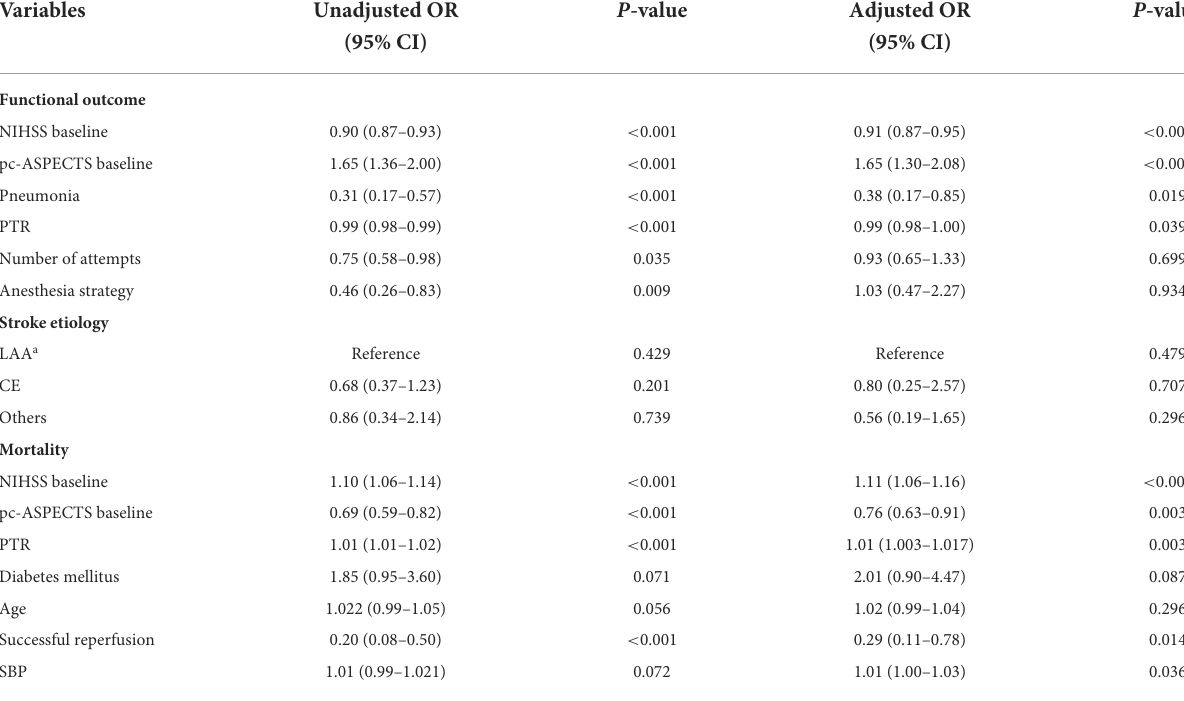
TABLE 3 Multivariable analysis: predictors of clinical outcome (mRS 0–3, mortality) in the EVT group. Variables Unadjusted OR P -value Adjusted OR (95%